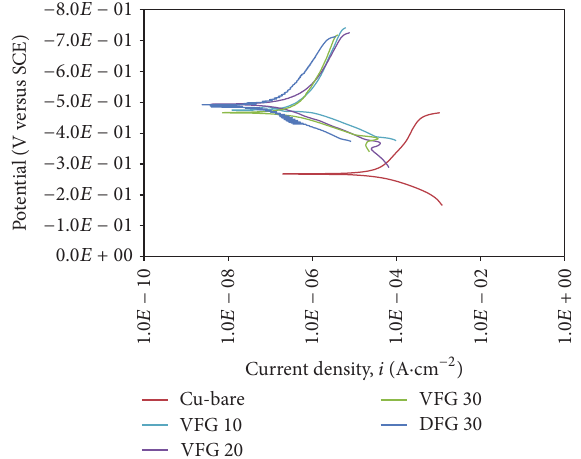
Figure 9: Potentiodynamic polarization curves of copper substrate and the superhydrophobic surfaces prepared with different degrees of fluorination and modification techniques in 3.5 wt.% NaCl solu-